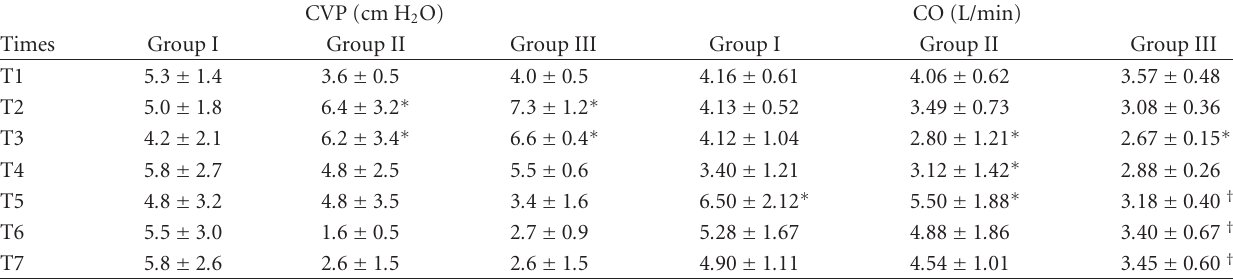
Table 2: Central venous pressure (CVP), cardiac output (CO) in pigs anesthetized with sevoflurane, fentanyl, and vecuronium and un- dergoing aortic cross-clamping through laparotomy (Group I) or laparoscopy with (Group II) or without aortic cross-clamping (Group